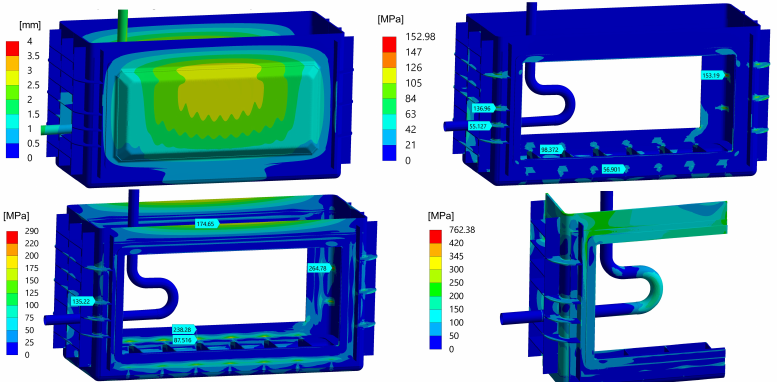
Figure 3. Top left : Deformation of the TLIC and the TLIC door due to primary stresses. Top right : primary membrane stresses of the main body; bottom left : primary membrane + bending stresses; and bottom right : primary membrane + bending stresses + secondary stress range.